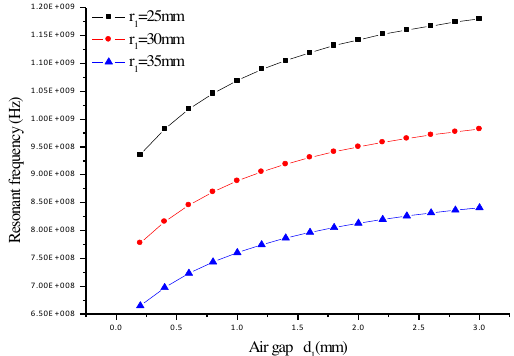
Figure 2: Resonant frequency versus air gap thickness for different values of patch radius, r =1.59mm, and ε d 2